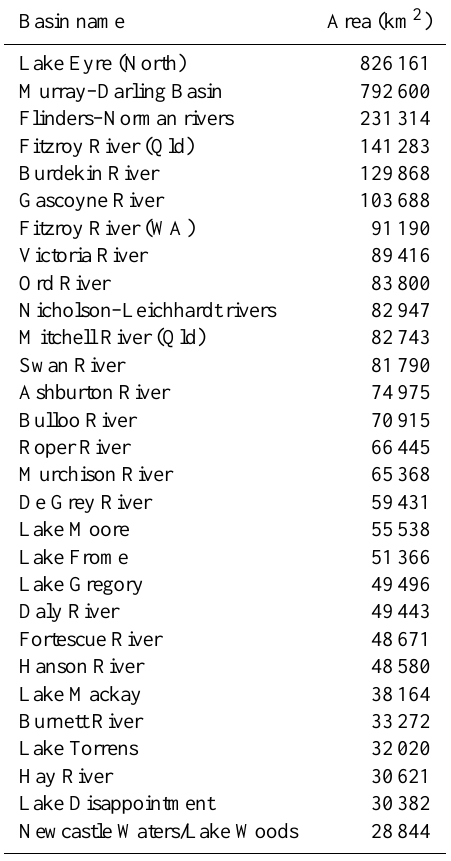
Table 1. Australia’s largest drainage basins with area > 25000km 2 .